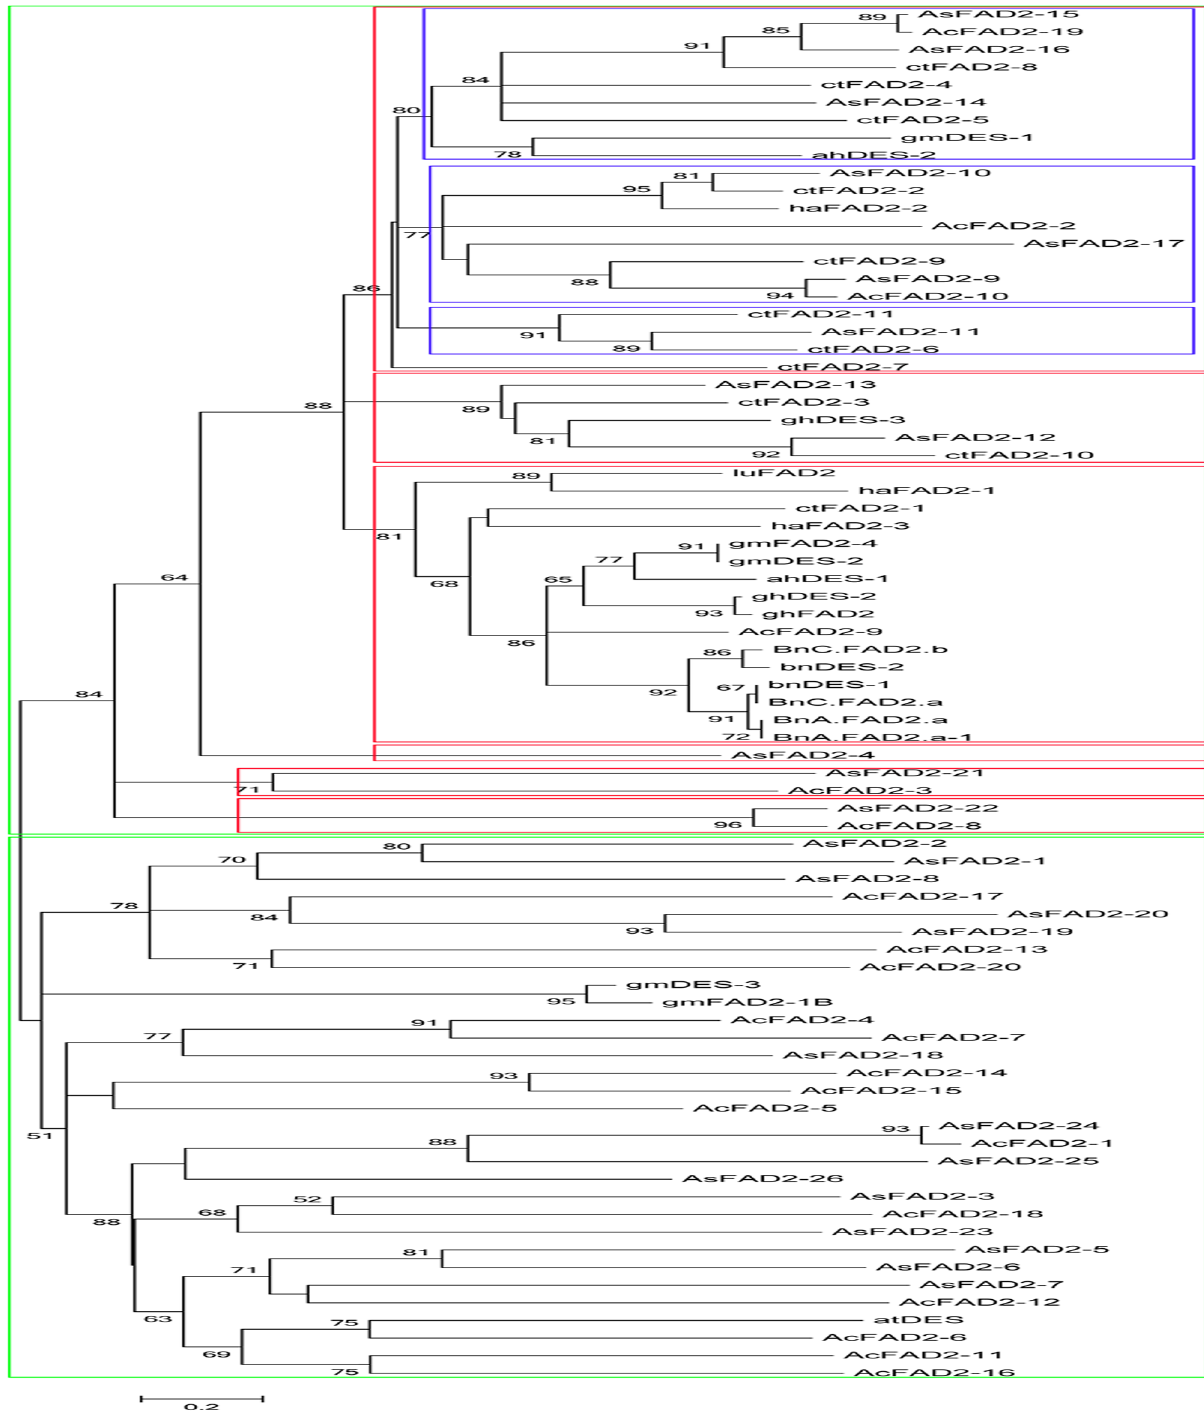
Fig 7. Phylogenetic comparison of Artemisia sphaerocephala AsFAD2s with FAD2s in other plants. Note: The phylogenetic tree was generated using Mega 5.0. The GenBank accession numbers of the amino acid sequences represented in the phylogenetic tree are as follows: CtFAD2-1, AGC65498.1; CtFAD2-2, AGC65499.1; CtFAD2-3, AGC65500.1; CtFAD2-4, AGC65501.1; CtFAD2-5, AGC65502.1; CtFAD2-6, AGC65503.1; CtFAD2-7, AGC65504.1; CtFAD2-8, AGC65505.1; CtFAD2-9; AGC65506.1; CtFAD2-10, AGC65507.1; CtFAD2-11, AGC65508.1; ghFAD2, AAQ16654.1; ghDES-2, AAL37484.1; ghDES-3, ADP02395.1; ahDES-1, ACZ06072.1; ahDES-2, AHN60569.1; gmFAD2-1B, ABF84062.1; gmFAD2-4, NP_001237865.1; gmDES-1, AAX29989.1; gmDES-2, AAB00860.1; gmDES-3, NP_001238342.1; BnA.FAD2.a-1, AFJ19029.1; BnA.FAD2.a, AFJ19030.1; BnC.FAD2.a, AFJ19031.1;